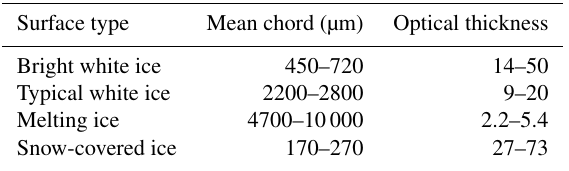
Table 6. Mean chords and optical thicknesses of different surface types (Malinka et al.,